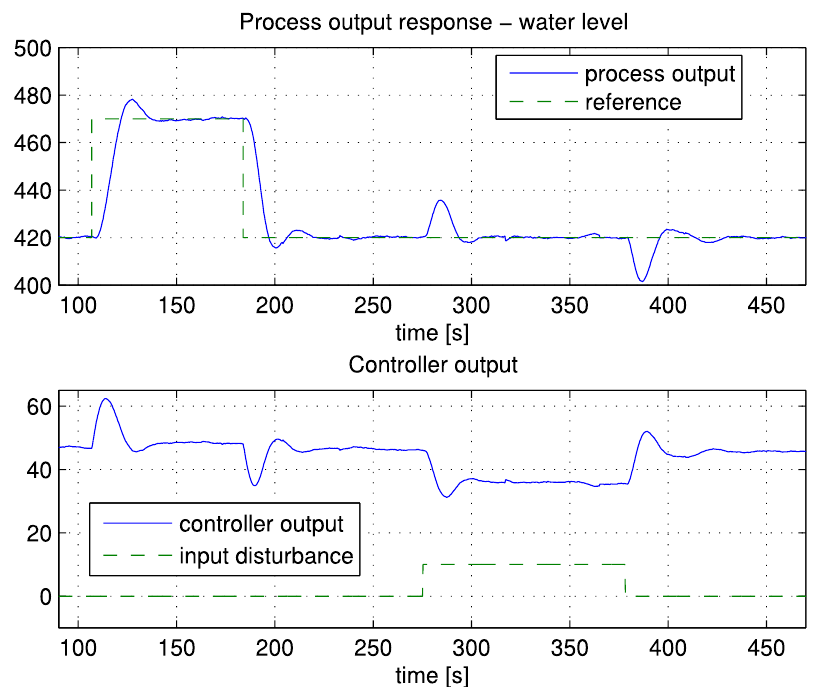
Figure 22. Process input (voltage on pump in %) and output (water level in mm multiplied by a factor of 2) signals during closed-loop experiment on hydraulic process.